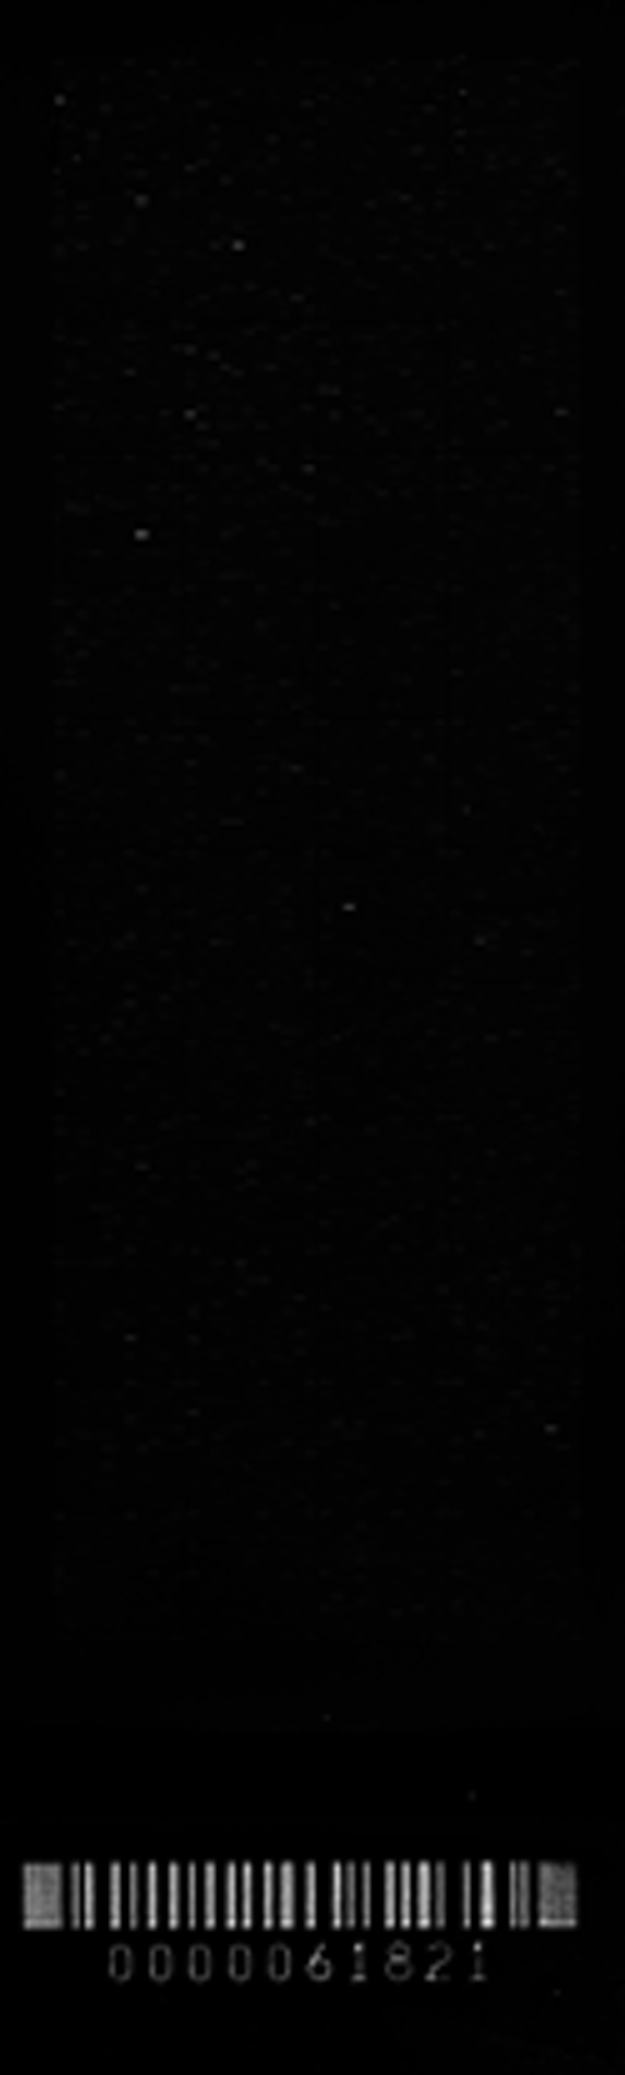
High Resolution Array Image. Positive control.